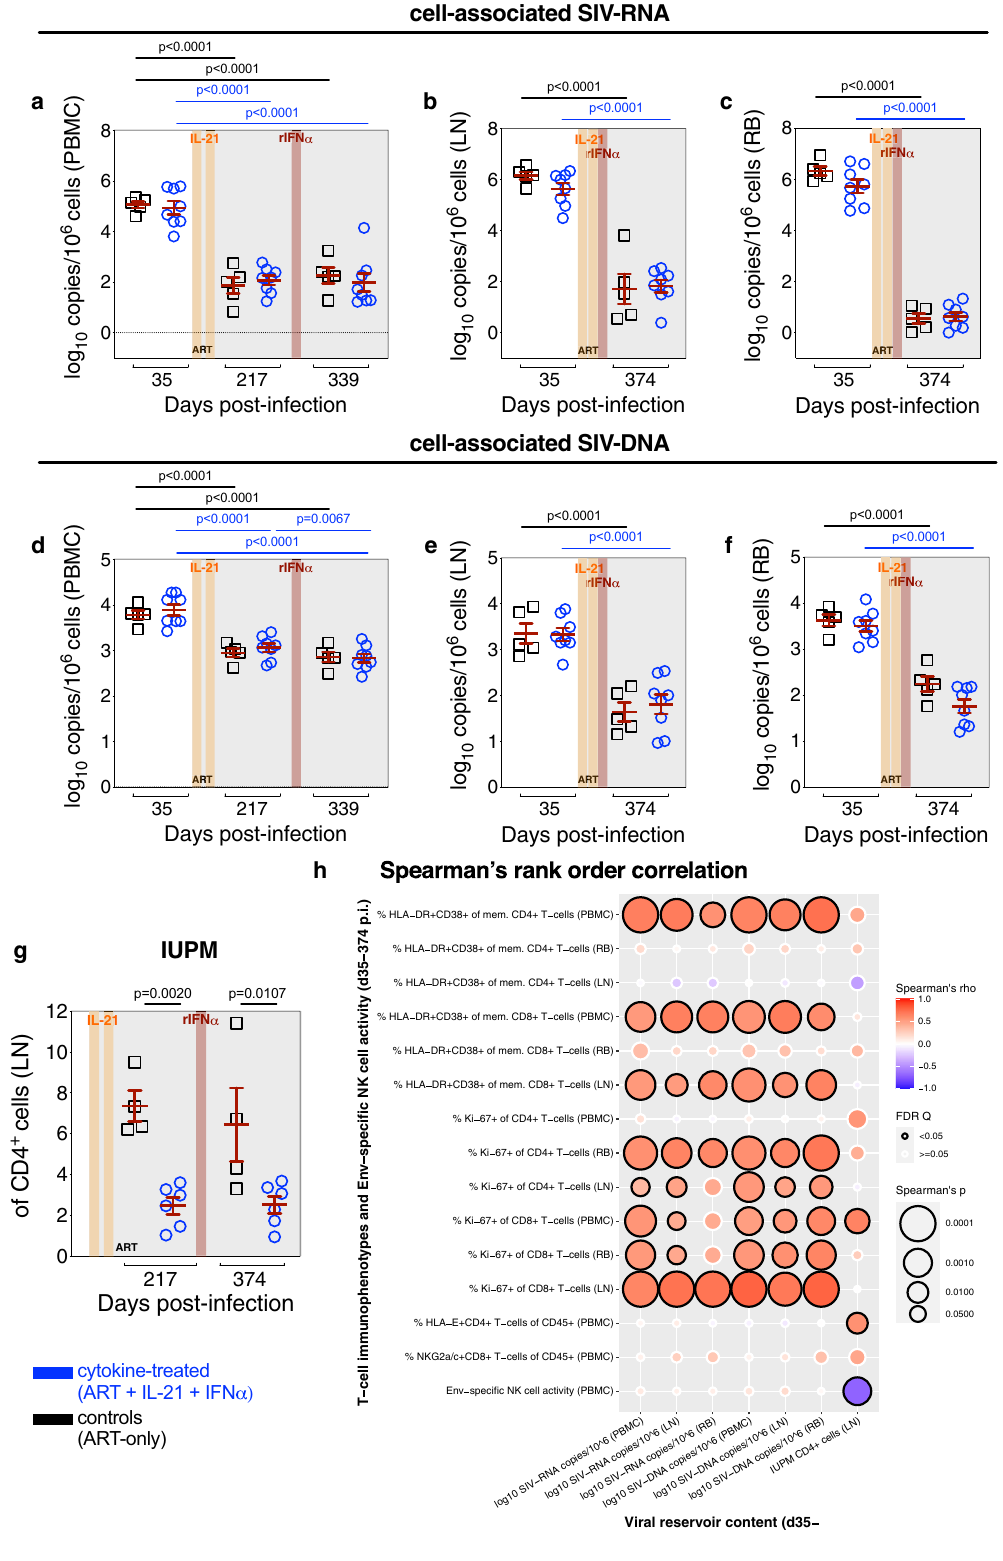
treated animals in contrast to higher levels of the intermediate (NKG2a/c high CD16 + , stage 2) NK cells with weak innate degra- nulation activity in the controls (Fig. 5b, c). In contrast, at d13 post ATI, the Env-speci fi c activity of bulk NK cells in cytokine-treated animals was no longer statistically signi fi cantly different from controls (Fig. 5d) and tended to converge with the levels observed in